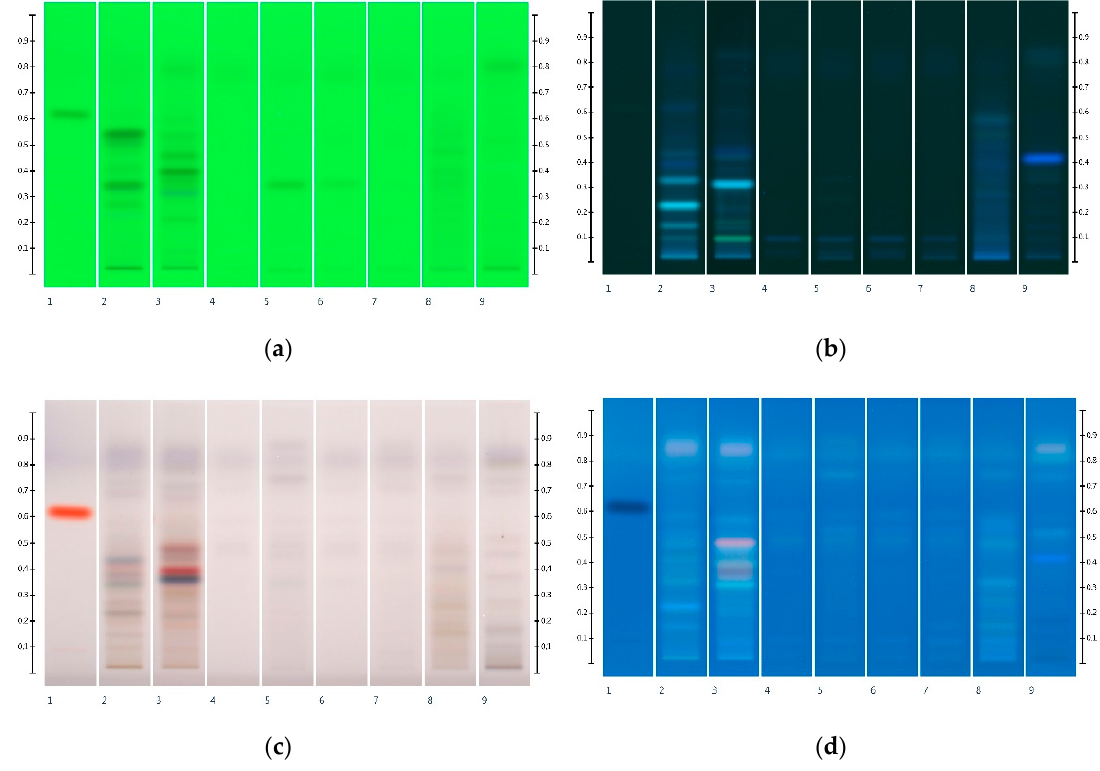
Figure 5. Images taken at ( a ) 254 nm; ( b ) 366 nm; ( c ) White light after derivatisation and ( d ) 366 nm after derivatisation with vanillin reagent; Track 1—4,5,7-trihydroxyflavanon, Track 2—MAN, Track 3—JAR, Track 4—COR, Track 5—RIC, Track 6—GLU, Track 7—GOL, Track 8—TRE, Track 9—MAP; 5 µL honey and syrup extracts respectively.